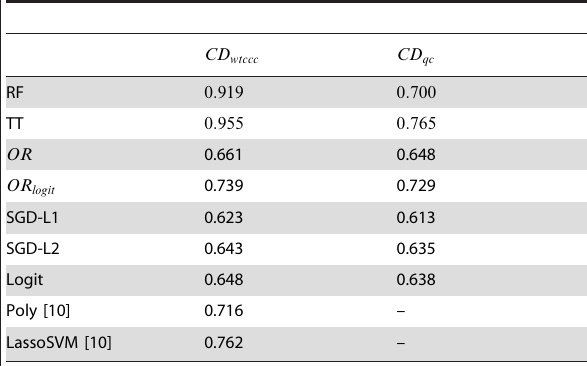
Table 5. Comparison of the predictive power of tree-based methods and linear